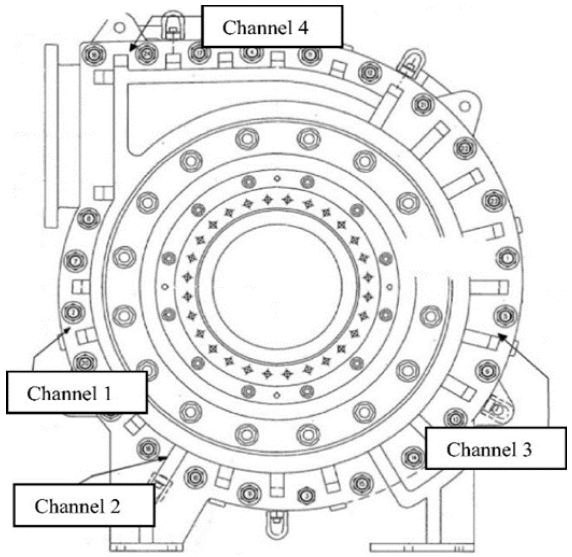
Figure 1. The measurement locations of the four accelerometers mounted on a slurry pump casing (the locations of the four accelerometers named as channel 1, 2, 3, and 4) [4].